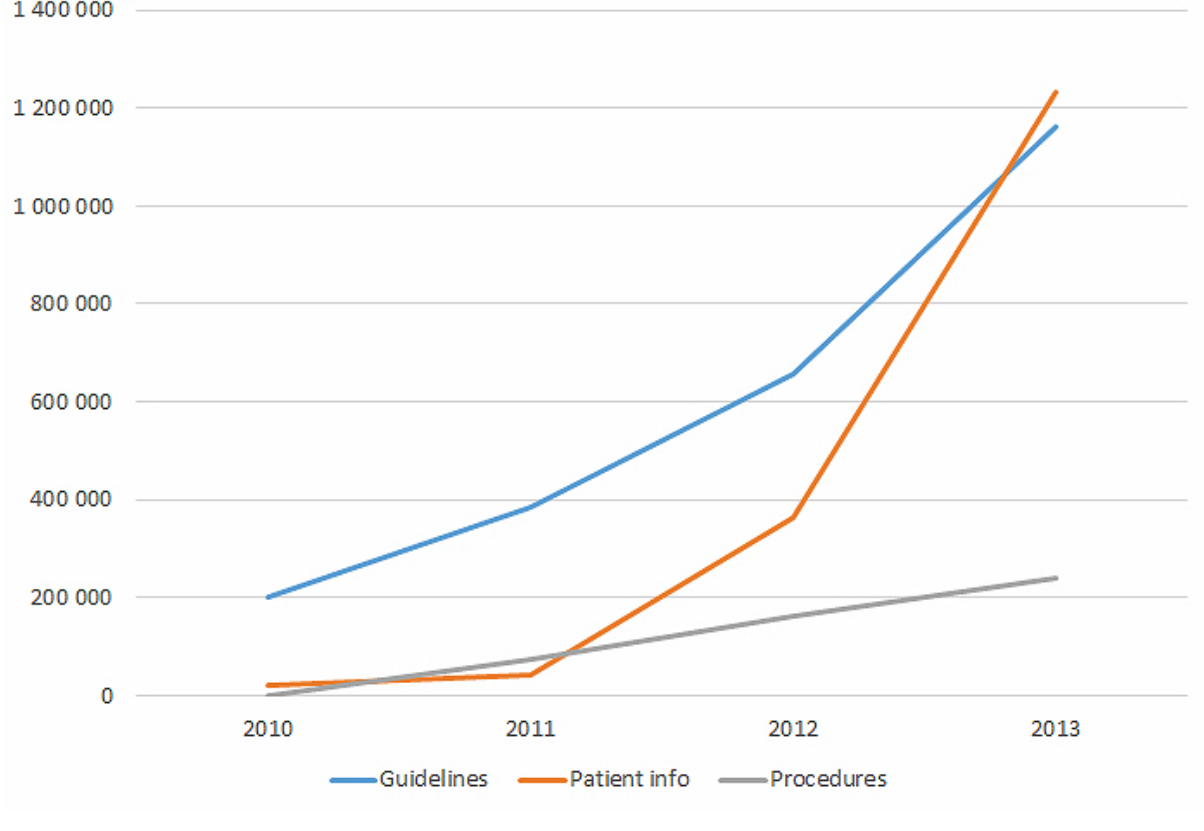
Figure 1. Pageviews of different information types on The Library website, Helsebiblioteket.no.